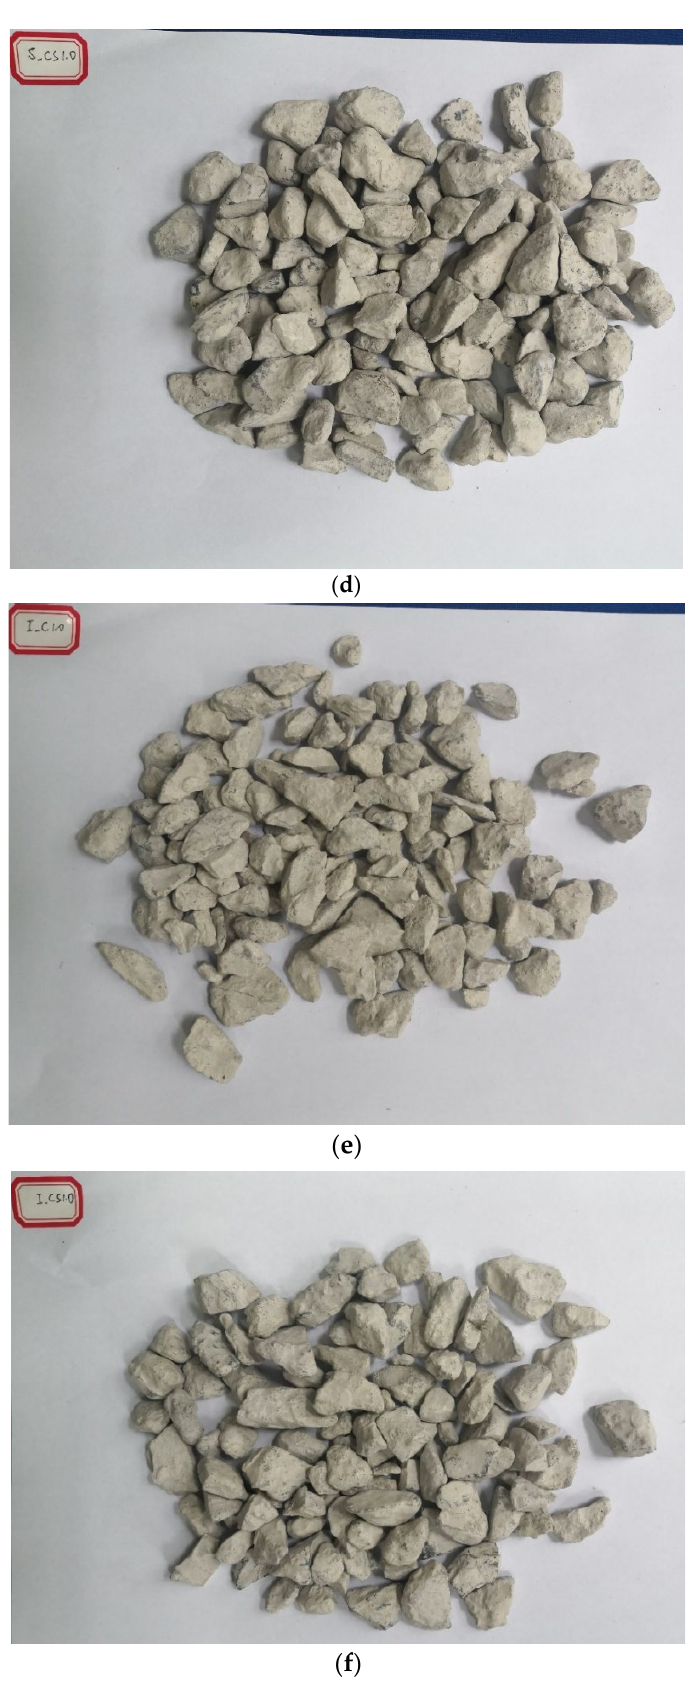
Figure 8. Images of the treated RCA. ( a ) S_C0.7; ( b ) S_C1.0; ( c ) S_C1.3; ( d ) S_CS1.0; ( e ) I_C1.0; ( f ) I_CS1.0.